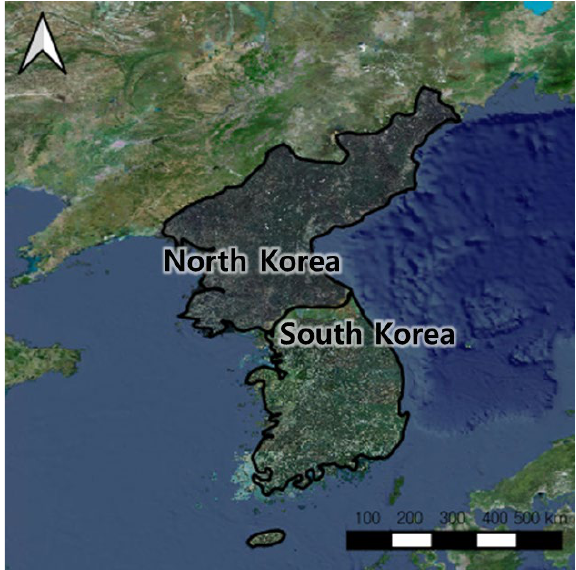
Figure 2. Location of study area.